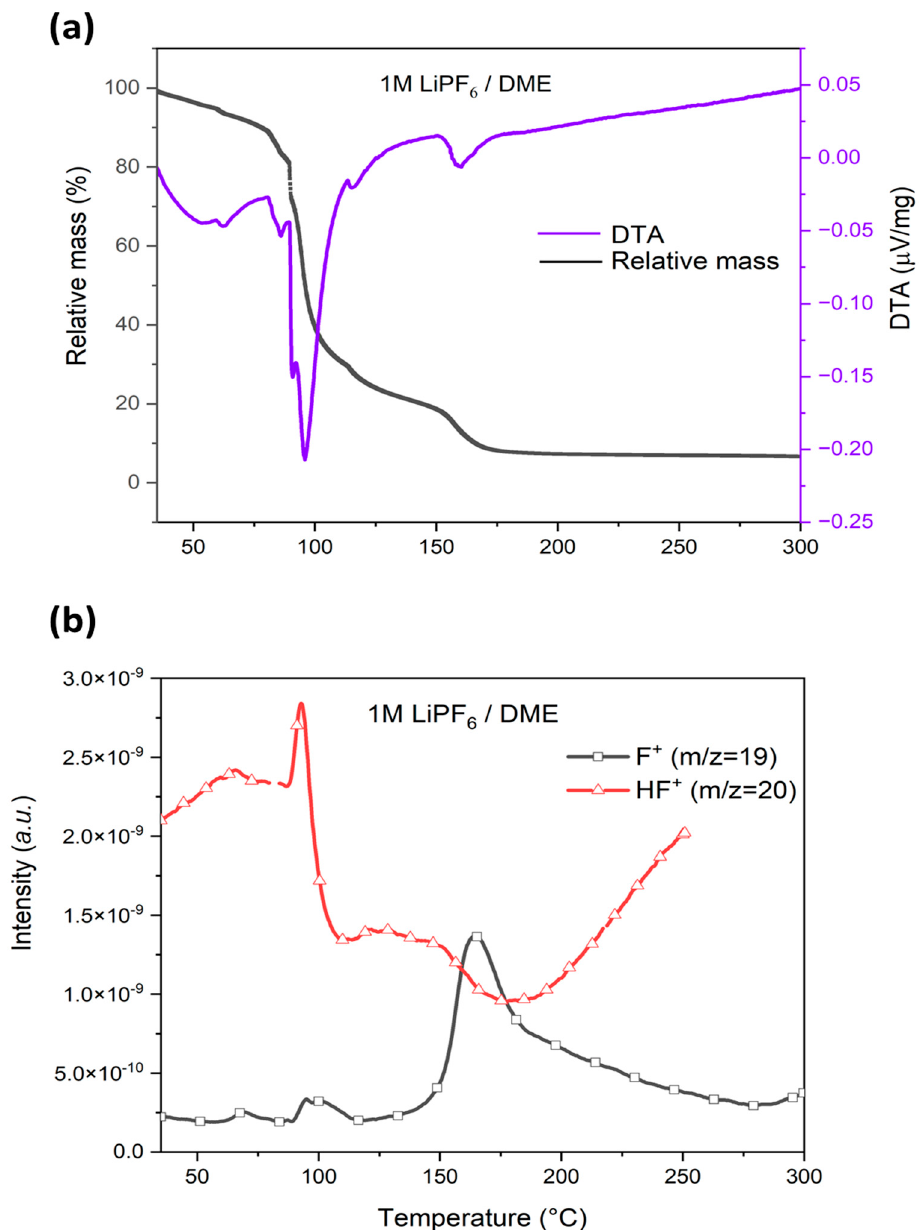
Figure 9. ( a ) TG/DTA curves of HF generation temperature in 1 M LiPF 6 /DME electrolyte solution without water, and ( b ) the simultaneous F + and HF + identification using MS.